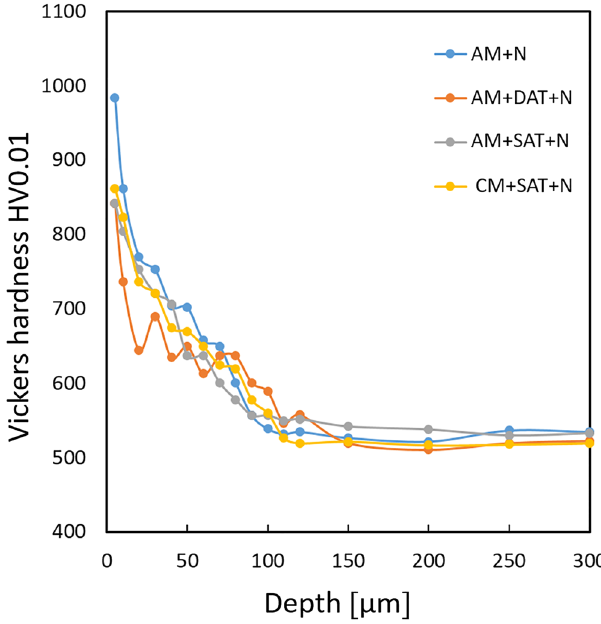
Figure 6. Microhardness depth profiles of: ( a ) AM + N, ( b ) AM + DAT + N, ( c ) AM + SAT + N and ( d ) CM + SAT + N samples.